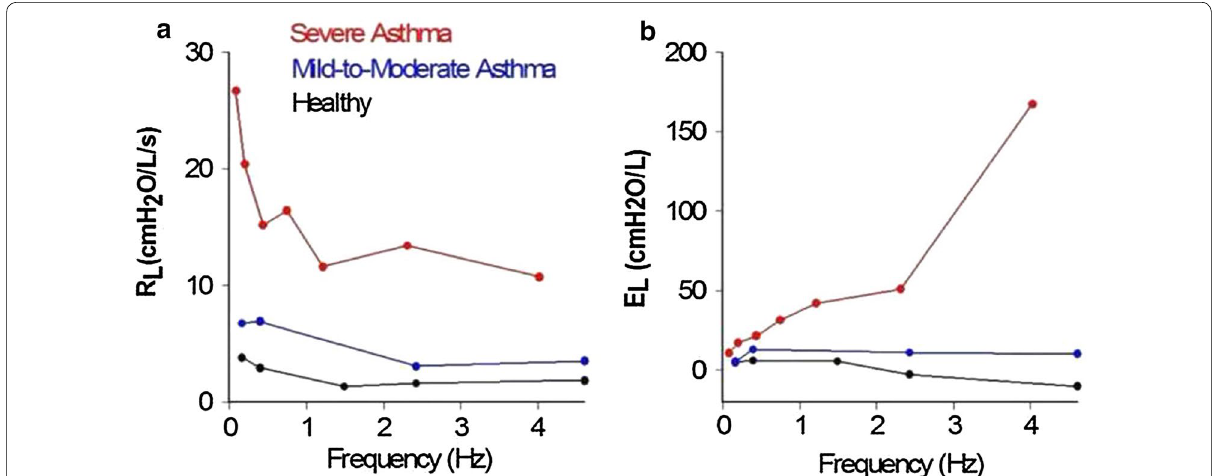
Fig. 3 Measured lung resistance ( a ) and lung elastance ( b ) over a wide array of frequencies using an OVW technique in healthy, mild-to-moderate asthma, and severe asthma. With increasing severity of disease, there is more frequency dependence in both R L and E L with significant shunting at high frequencies apparent in E L (adapted with permission from